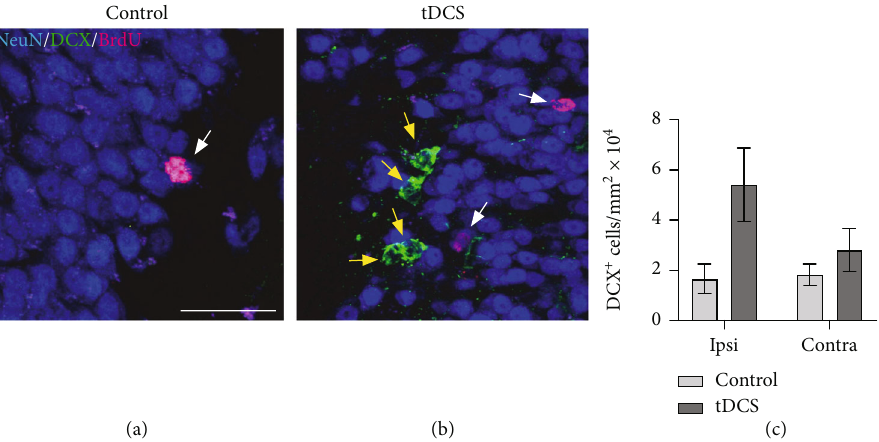
Figure 1: Increase of hippocampus neurogenesis in poststroke mice 14 days after receiving tDCS. (a) Compared to controls, in ES rats, we were able to identify a hippocampal increase in the number of (b) DCX (yellow arrows) and BrdU cells (white arrows). (c) This e ff ect was seen in both the ipsilateral (Ipsi) and contralateral (Contra)